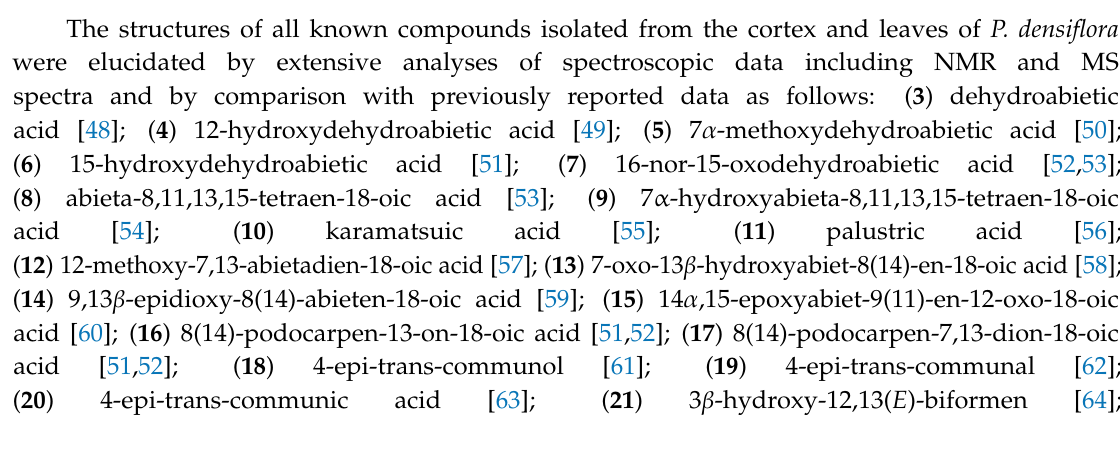
Figure 1. ( A ) Key HMBC (arrows) and COSY (bold) correlations of compounds 1 and 2 . ( B ) Data from the modified Mosher’s method for 2a.